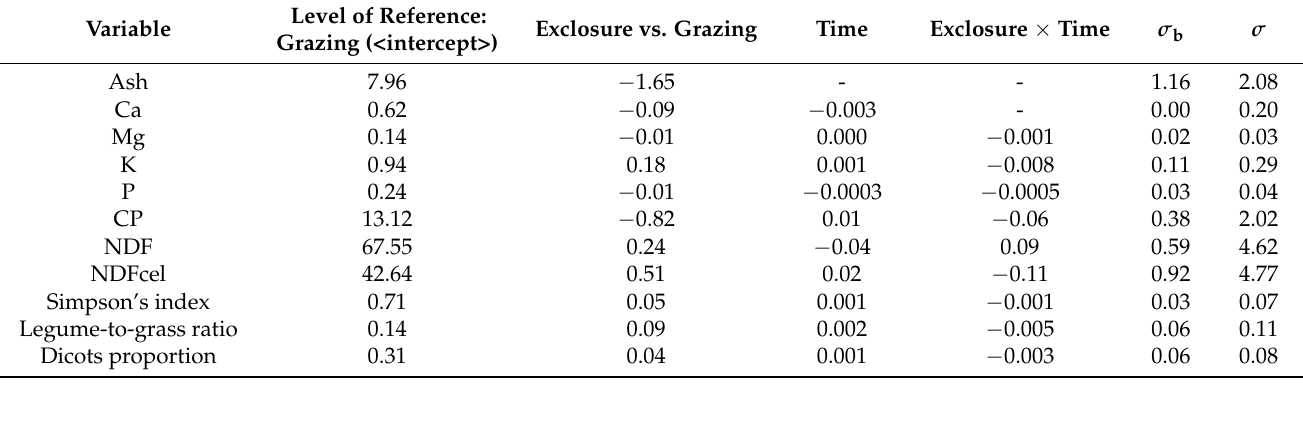
Table 2. Restricted maximum likelihood parameter estimation for the forage quality properties and floristic composition measured in four field sites during 2005–2010. The parameter σ b corresponds to the variability due to the random factor Site; the parameter σ corresponds to the residual variability. Cage vs. grazing has been omitted, since, in most cases, these effects are not significant (Supplementary Table S3). Hypothesis testing is reported in Table 1.